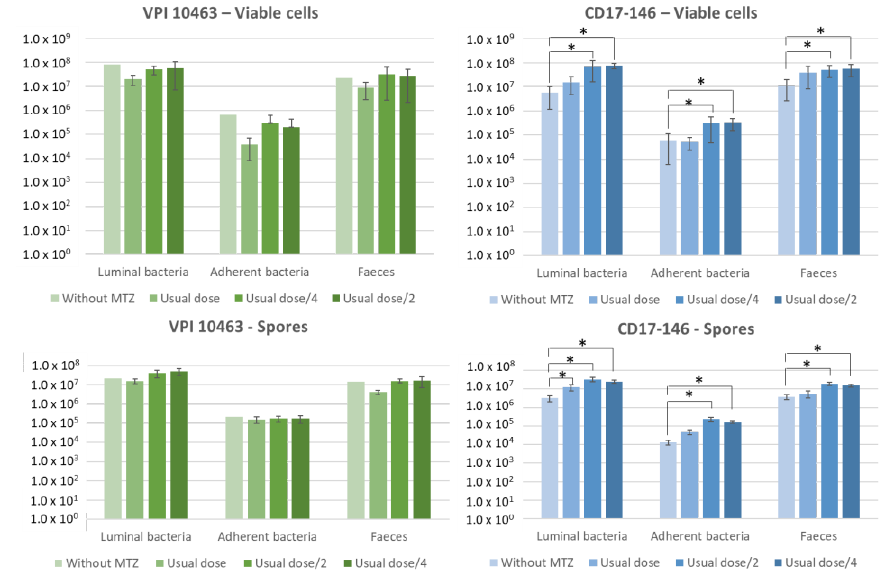
Figure 7. Impact of MTZ on cecum colonization of C. difficile in conventional mice, 7 days post- infection. Conventional mice were infected by either VPI 10463 (green) or CD17-146 (blue) with equivalent number of vegetative cells. Colonization process and bacterial burden were monitored by seeding fecal, cecal contents (luminal bacteria) and homogenized mucosal tissues (adherent bacteria) on selective plates at day 7 post-infection. Low doses (usual dose/4 and usual dose/2) of MTZ stimulated the colonization of CD17-146. Data generated from two independent experiments. The error bars represent standard error of the mean (SEM). Significant differences ( p < 0.05) compared to group without treatment are indicated by asterisks (Man-Whitney test).